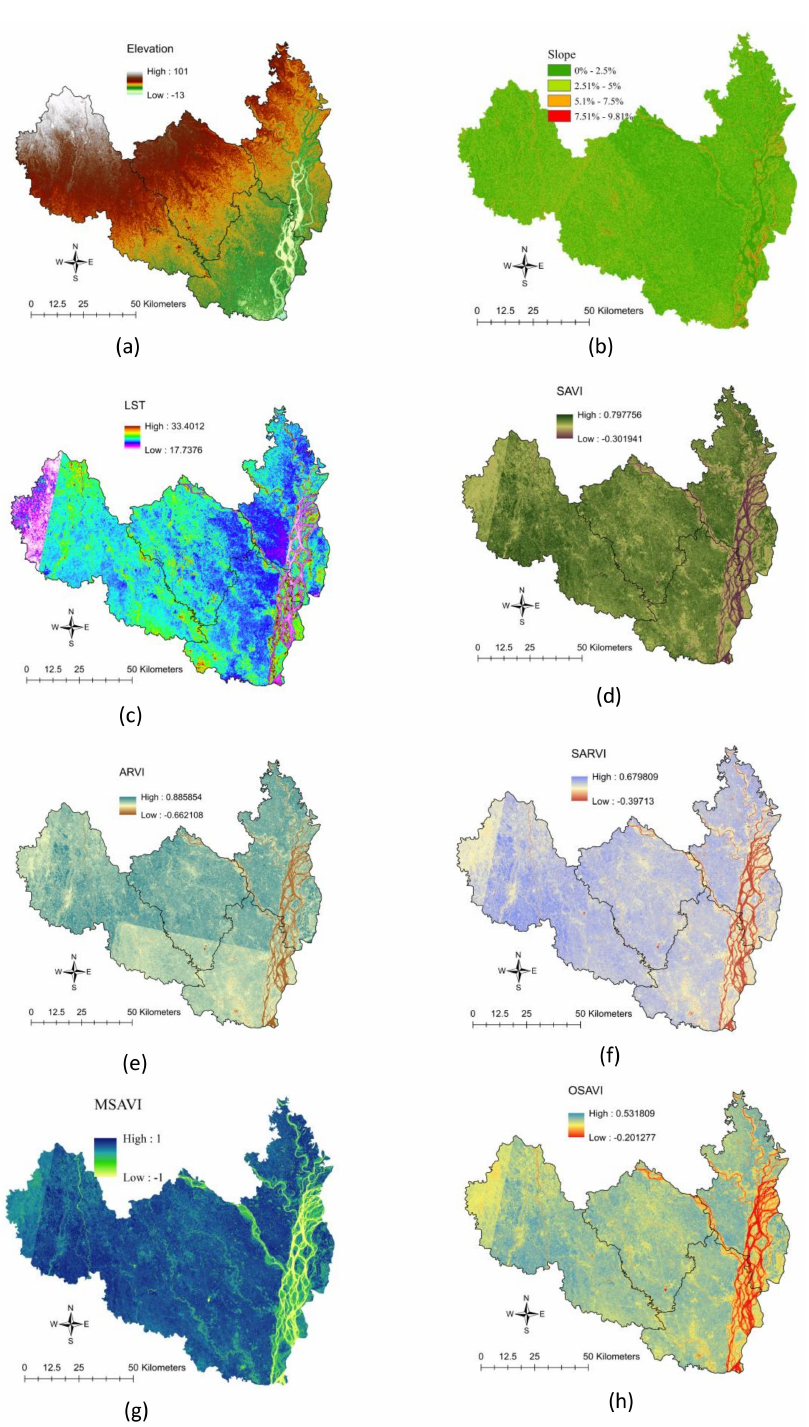
Figure 3. Criteria: ( a ) Elevation, ( b ) Slope, ( c ) LST, ( d ) SAVI, ( e ) ARVI, ( f ) SARVI, ( g ) MSAVI ( h )